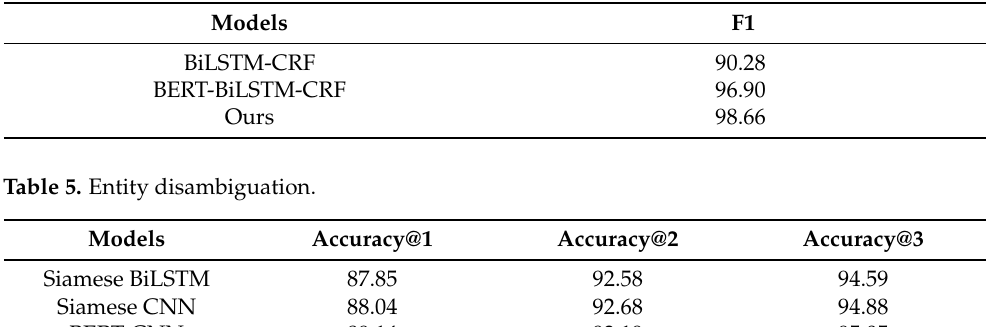
Table 4. Named Entity Recognition.